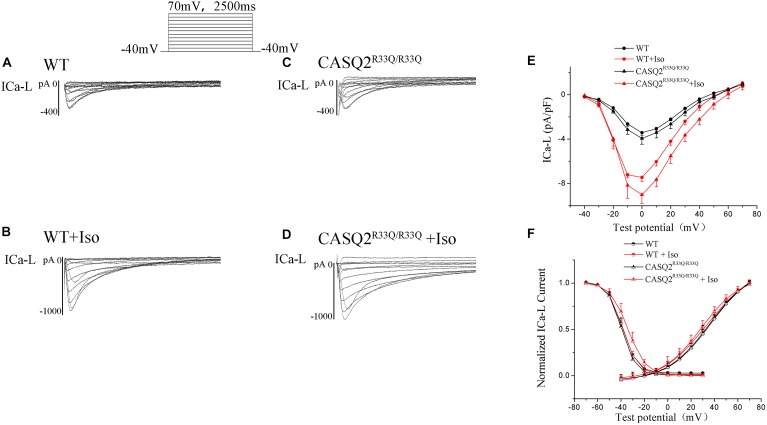
(A–D) The ICa-L in the Casq2R33Q/R33Q and WT groups with or without Iso. ICa-L current traces in 10 mV increments from a holding potential of –40 mV to +70 mV in the WT and the Casq2R33Q/R33Q atrial myocyte groups. (E) The current–voltage relation curve (I–V curve) for ICa-L. (F) SSA and SSI for ICa-L in the Casq2R33Q/R33Q and the WT groups with and without Iso.